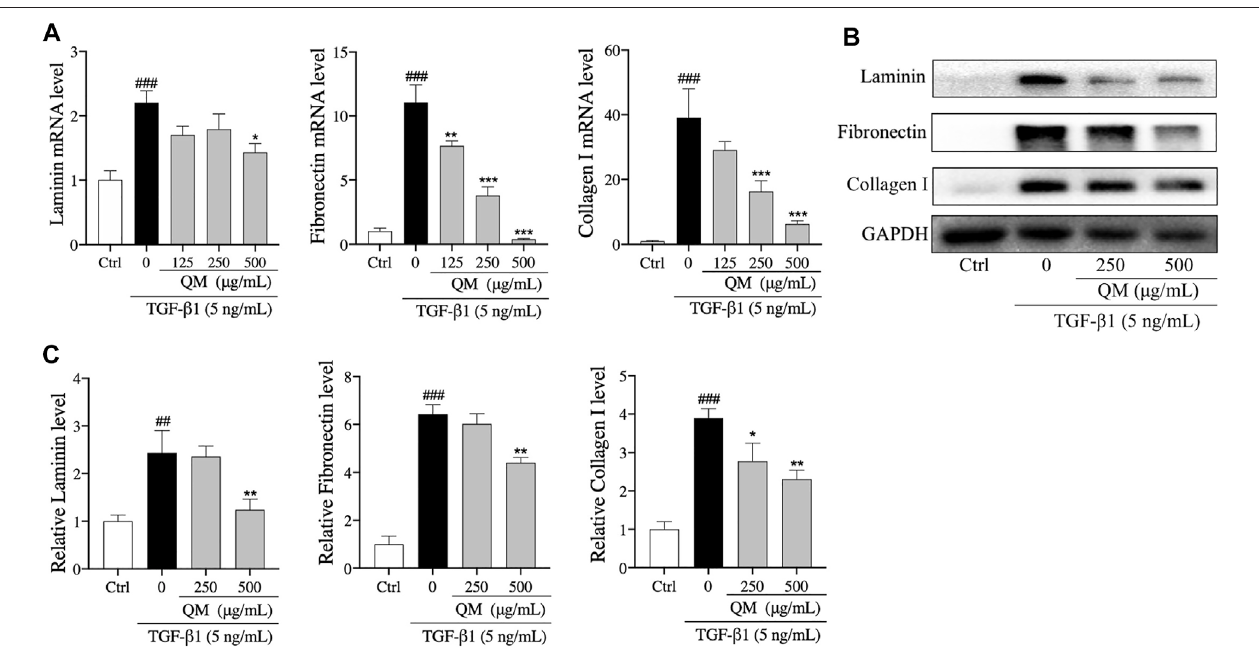
FIGURE 6 | QM promoted the degradation of ECM in TGF- β 1 – induced A549 cells. (A) After incubation with TGF- β 1 and/or QM for 72 h, qPCR analysis was performedandtherelativemRNAlevelsoflaminin, fi bronectin,andcollagenIinA549cellswerecalculatedandnormalizedtoGAPDH. (B,C) Theproteinlevelsoflaminin, fi bronectin,andcollagenIinA549cellstreatedwithTGF- β 1and/orQMfor72 hweredeterminedbyWesternblotanalysis.GAPDHwasusedastheloadingcontrol.Data are from three independent experiments. ## p < 0.01, ### p < 0.001 versus the control group; * p < 0.05, ** p < 0.01, and *** p < 0.001 versus the model group (TGF- β 1, 5